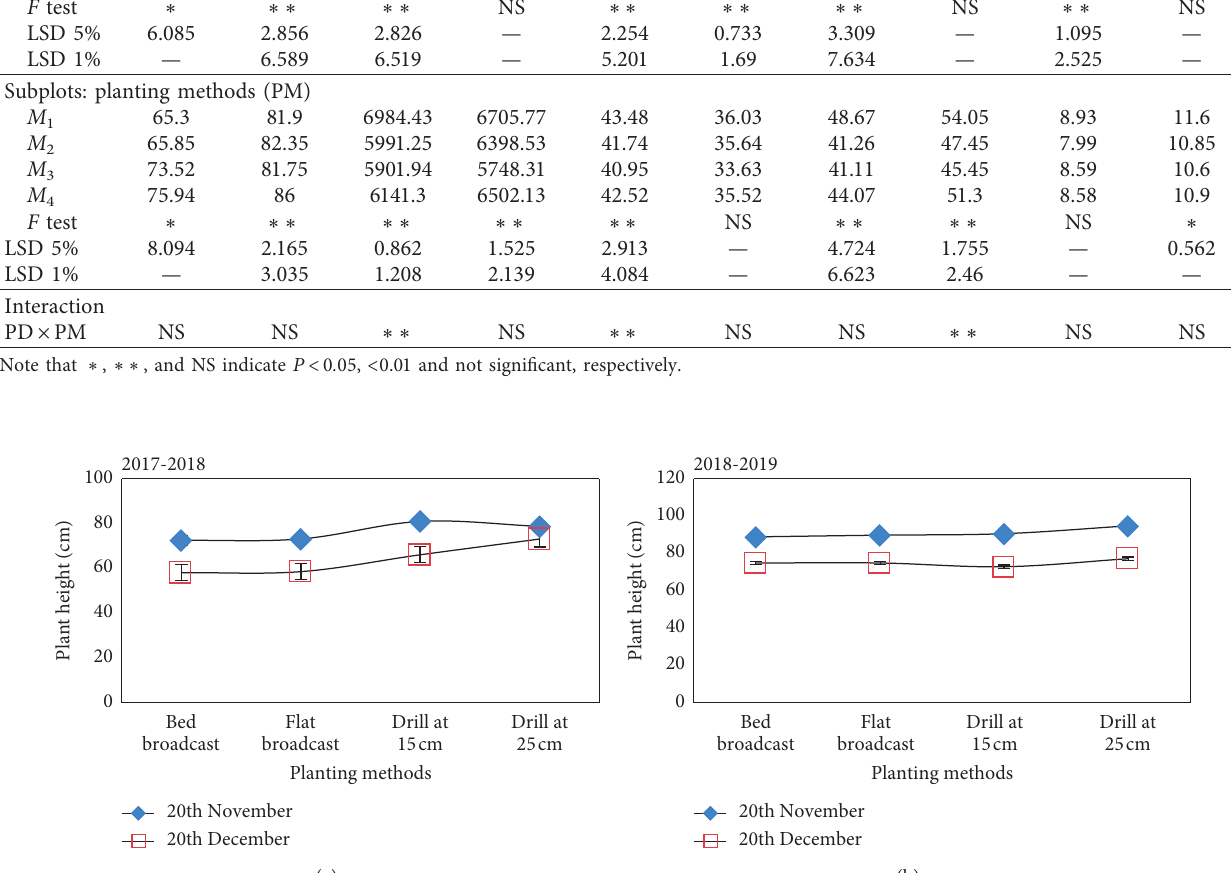
Table 5: Effect of planting dates and planting methods on plant height, grain yield, 1000-grain weight, no. of grain spike − 1 , and spike length in the first and second growing seasons. Treatments Main plots: planting dates (PD)